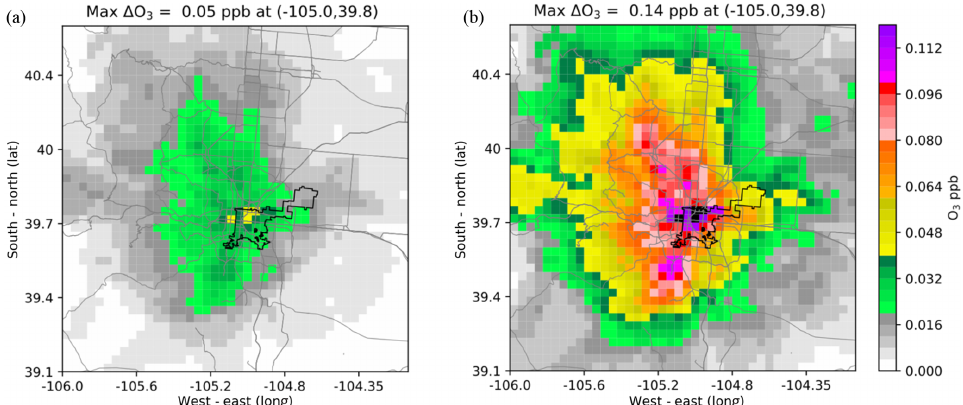
Figure 7. The predicted maximum increases in the maximum daily average 8h (MDA8) ozone concentration (ppb) for the (a) 5_DPW and (b) 3_EC scenarios for the Denver region over the 90d simulation period. The black indicates ozone increase values greater than